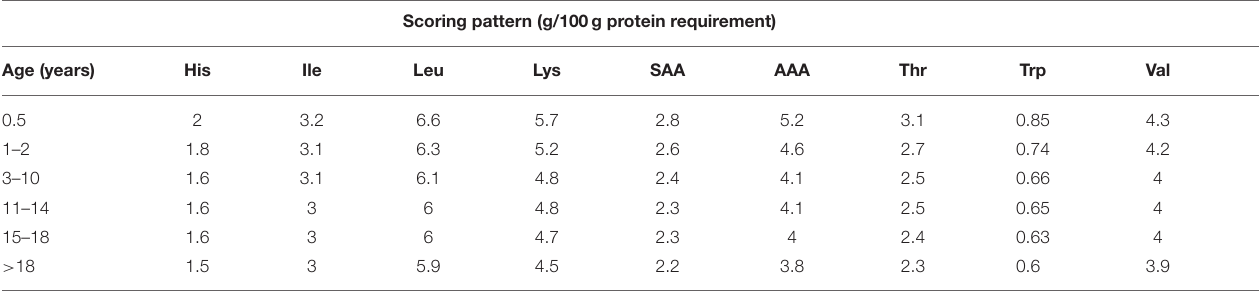
TABLE 4 | Daily requirements for essential amino acids presented as scoring patterns (amino acid requirements/protein requirements for the selected age groups) for all age groups considered. Scoring pattern (g/100g protein